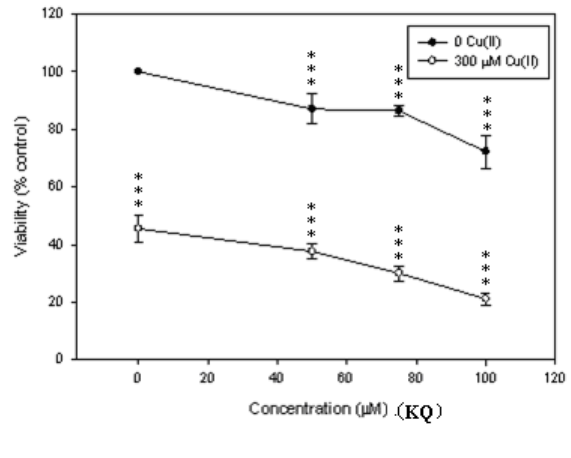
Figure 5. KQ potentiates cupric ion-induced SCM-1 cell death. Cell viability was assessed by the MTT assay 48 h after treating with different concentrations of KQ with or without Cu(II). *** p < 0.001 represents significant differences compared with control values.